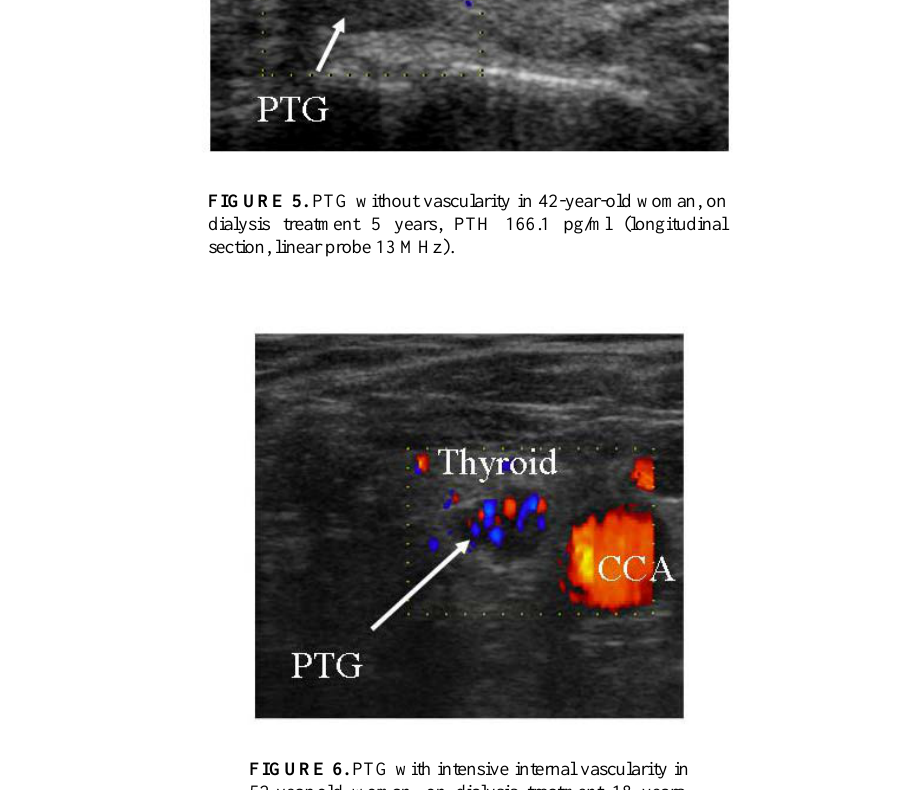
FIGURE 6. PTG with intensive internal vascularity in 52-year-old woman, on dialysis treatment 18 years, PTH 712.3 pg/ml (transversal section, probe 10